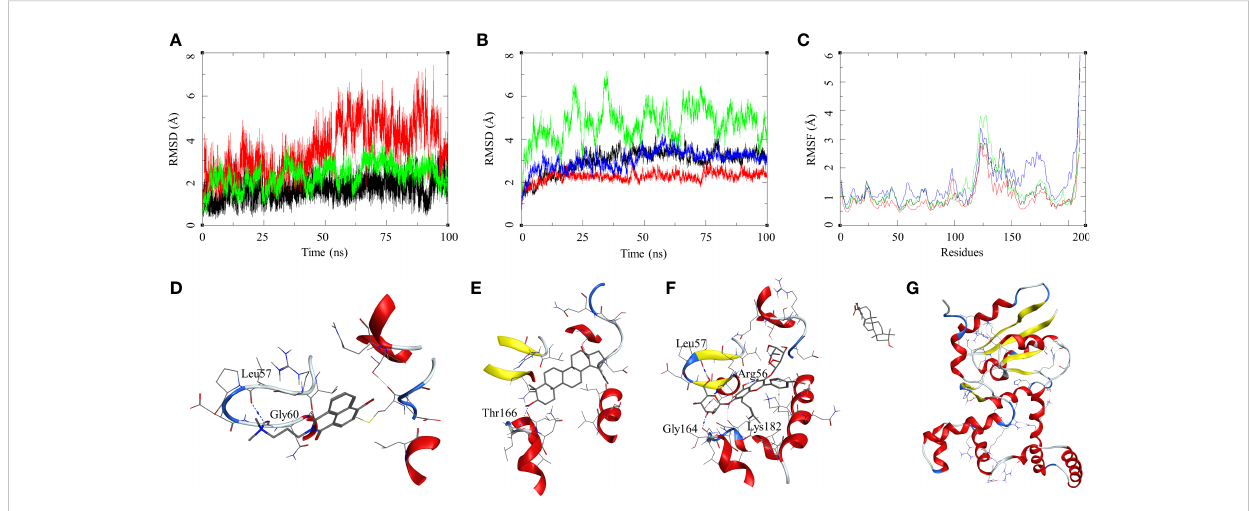
FIGURE 4 Molecular dynamics simulation results for M. smegmatis dormancy survival regulator (DosR) complexes: (A) ligand RMSD for HC104A (black), BA (red), and IC (green); (B) ligand-bound protein RMSD for HC104A (black), BA (red), IC (green), and UA (blue); (C) ligand-bound protein RMSF for HC104A (black), BA (red), IC (green), and UA (blue). Protein – ligand complex poses at the end of the 100-ns simulations, (D) DosR-HC104A, (E) DosR – BA, (F) DosR – IC, and (G) DosR –